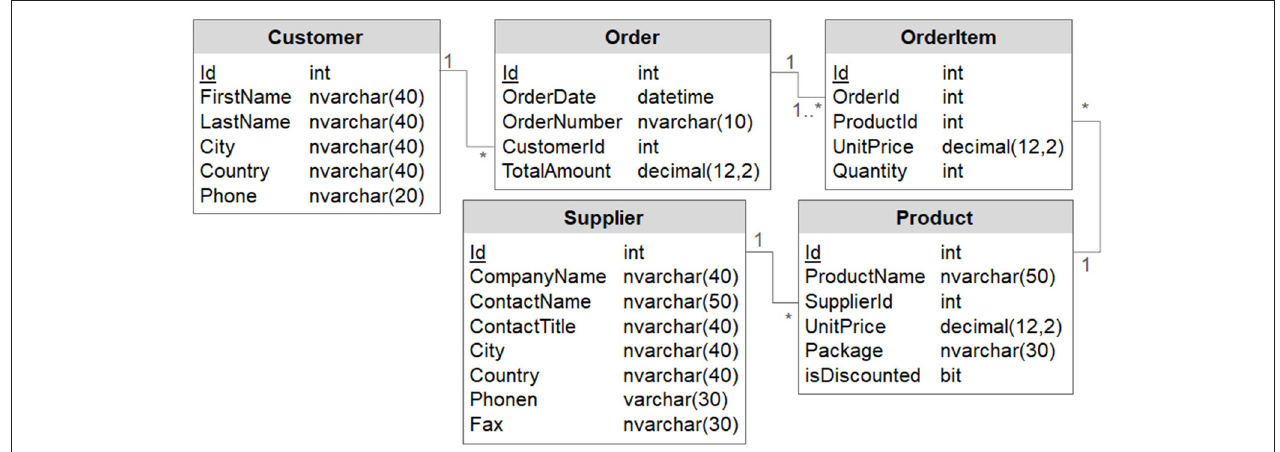
FIGURE 2 | Schema of the northwind evaluation